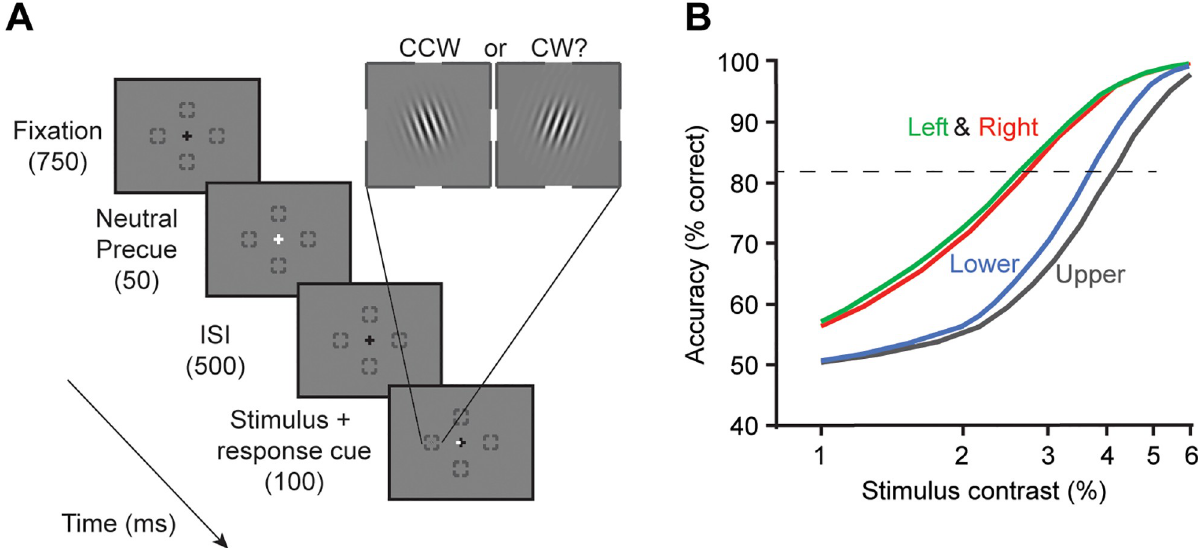
Fig 1. Example of psychophysical task and performance differences ‘around’ the visual field. (A) Experimental design of a two-alternative forced choice (2-AFC) orientation discrimination task. While observers maintained fixation, a brief cue appeared, and after a 500 ms ISI, a Gabor stimulus (4 cycles/˚) was presented at one of four possible iso-eccentric locations (4.5˚ eccentricity). A response cue indicated to the observer the target location they were asked to make an orientation judgment on (clockwise/CW or counter-clockwise/CCW relative to vertical). Contrast varied across trials. (B) Contrast-dependent psychometric functions of an example observer show best performance for the two horizontal locations (Left and Right), and poorest performance for upper vertical. The increase in contrast thresholds (contrast at which performance reached 82% correct, dashed line) ranged from about 2.5% (Left and Right) to 4% (Upper). Data from figure 6 in Cameron, Tai, and Carrasco [5].